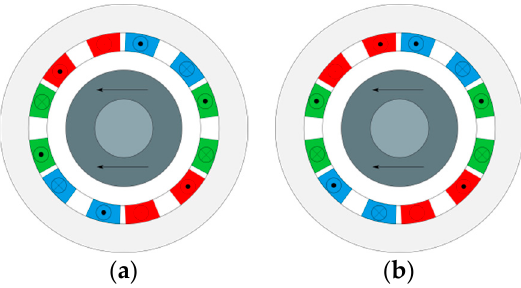
Figure 6. Schematic view of the prototype, with the current directions inside each phase resulting in